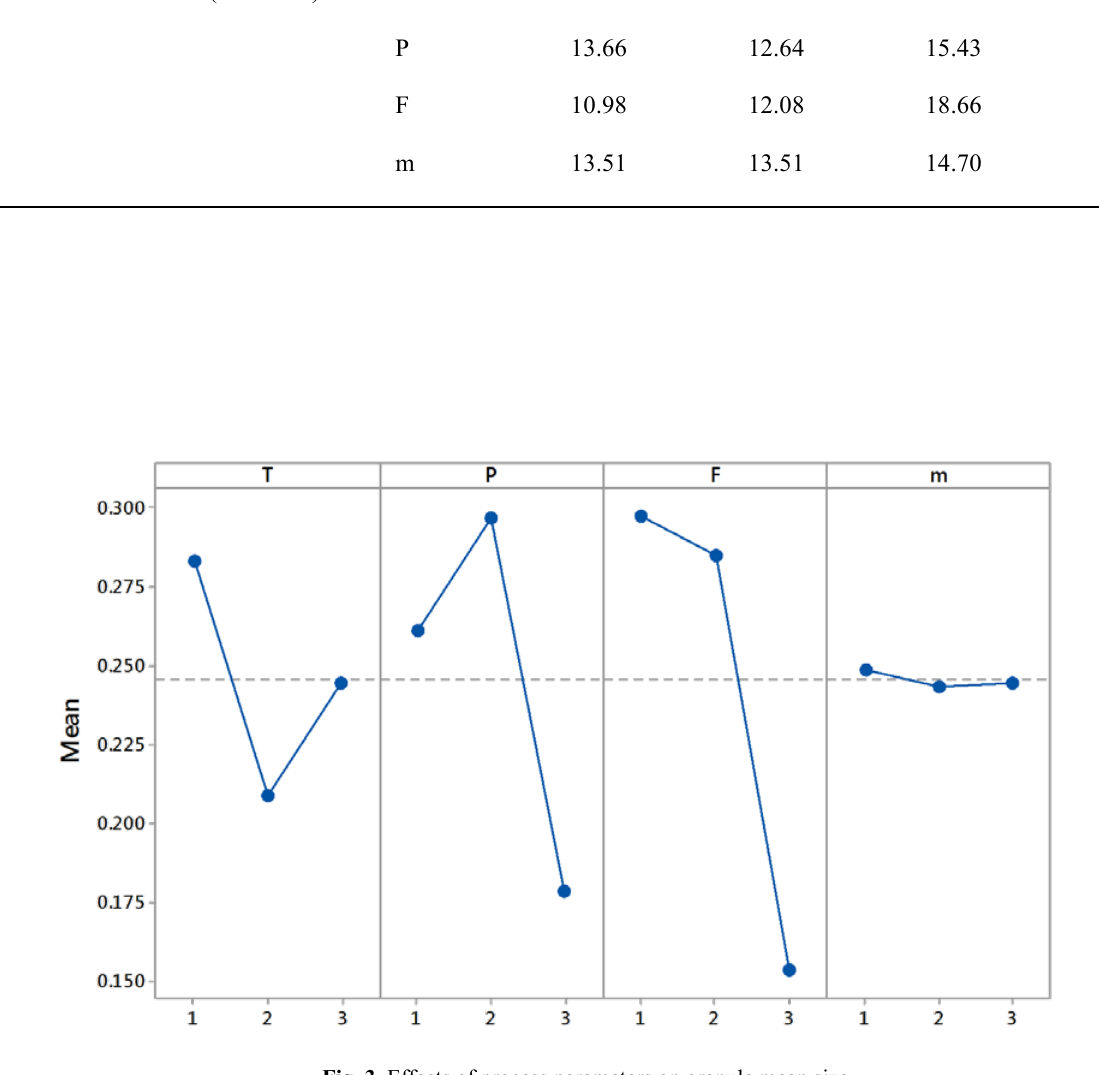
Fig. 3. Effects of process parameters on granule mean